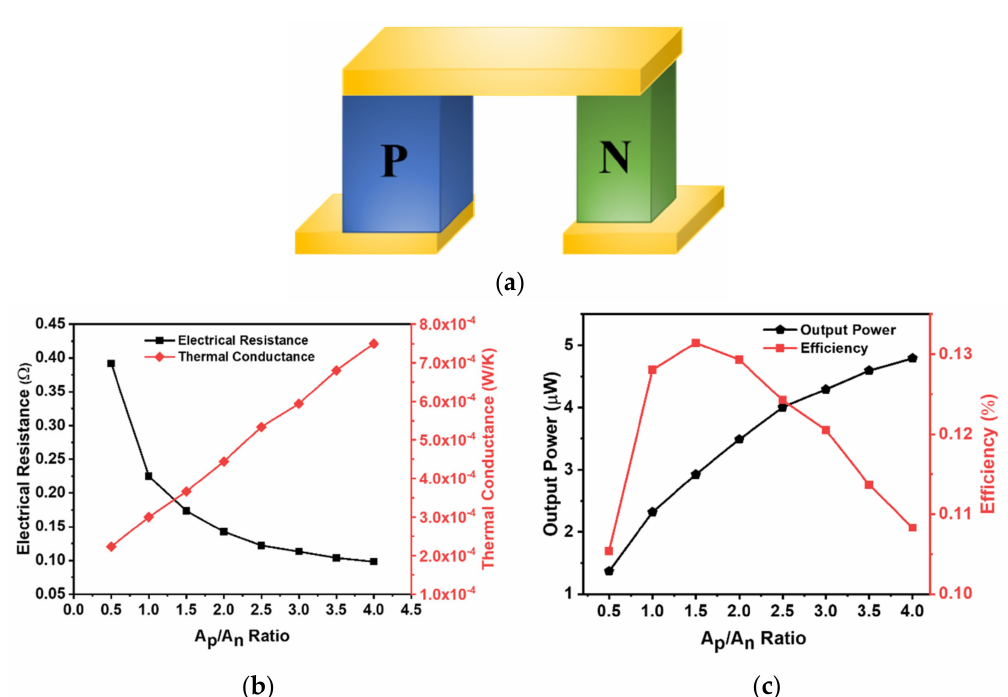
Figure 7. ( a ) Schematic of single-leg pair TEG with a different cross-sectional area of p- and n-type legs; ( b ) electrical resistance and thermal conductance of single-leg pair as a function of Ap / An ratio; ( c ) power output and efficiency of single-leg pair for different Ap / An